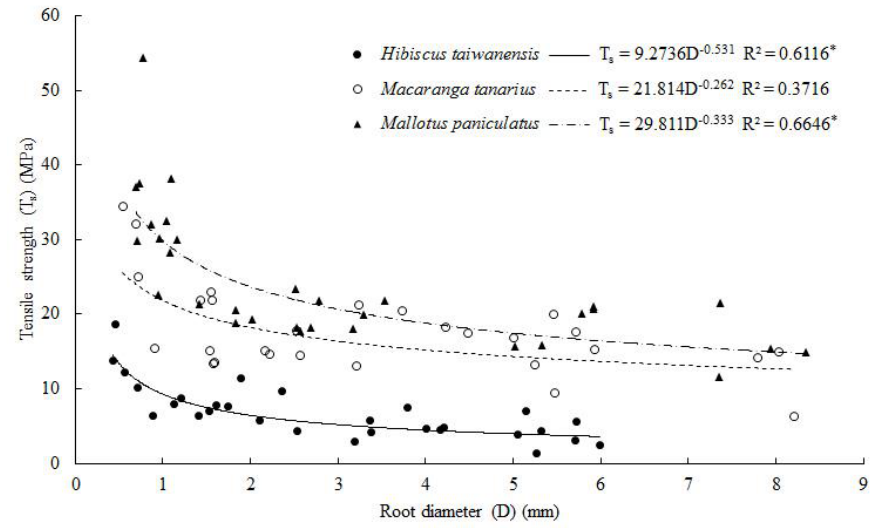
Figure 5. Relationship between root tensile strength and root diameter for the three studied species fitted to a power law function.